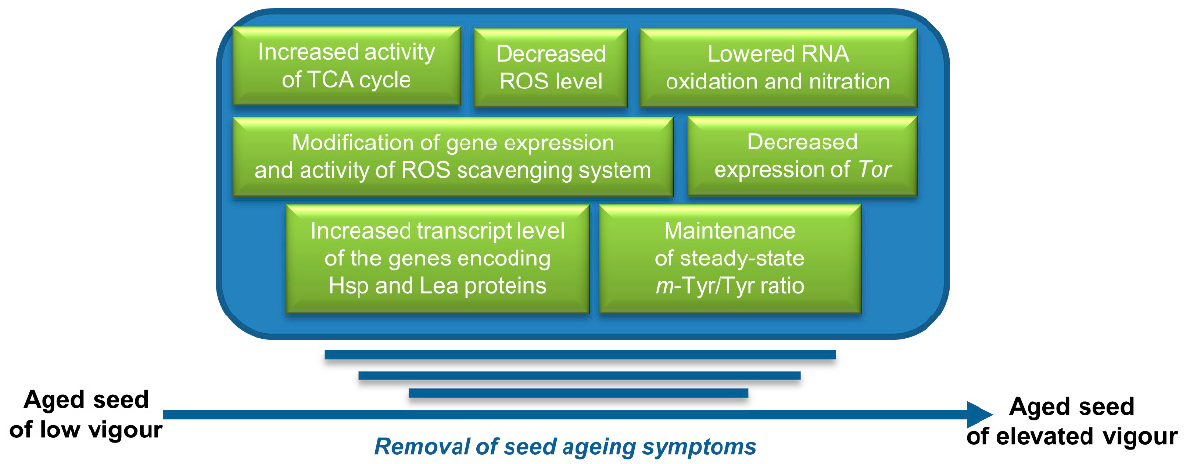
Figure 5. Changes observed after treatment of aged seeds with NO (SNP or other donors) leading to the restoration of seed metabolism, resulting in the removal of typical physiological features of seed aging (low vigour and low germinability). The course of events indicated in the figure does not reflect their actual sequence.